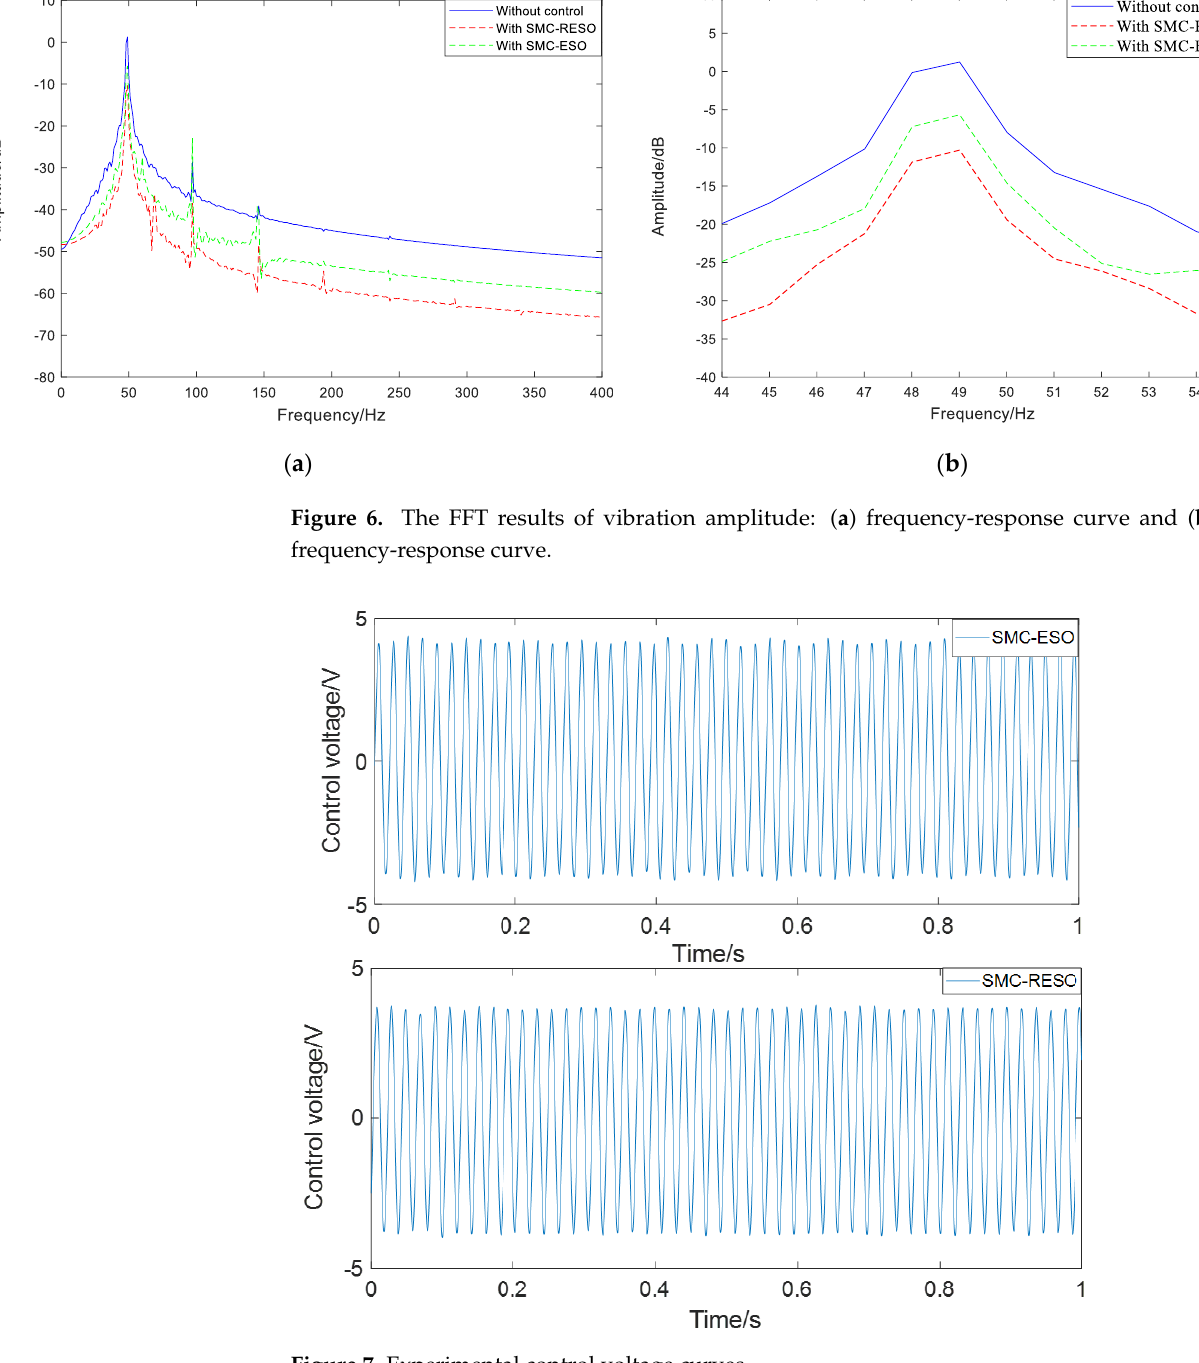
Figure 7. Experimental control voltage curves. Table 2. Output amplitude of different controllers.